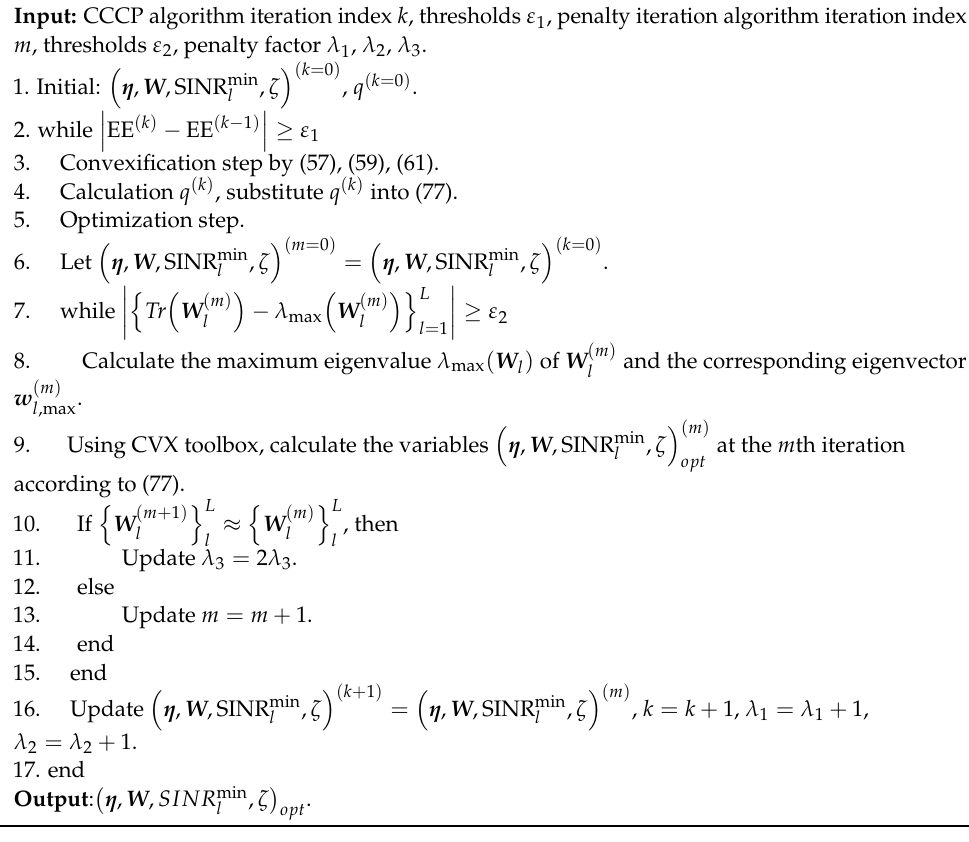
Algorithm 1: Joint user scheduling and hybrid beamforming design